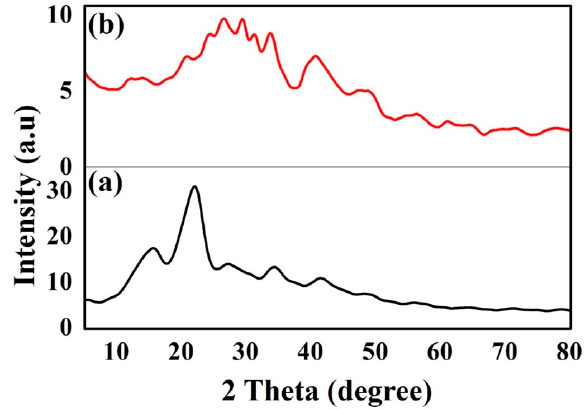
Figure 4. XRD spectrum for ( a ) raw date palm fibre (DPF) before activation ( b ) bio-powder activated carbon (bio-PAC) after activation.